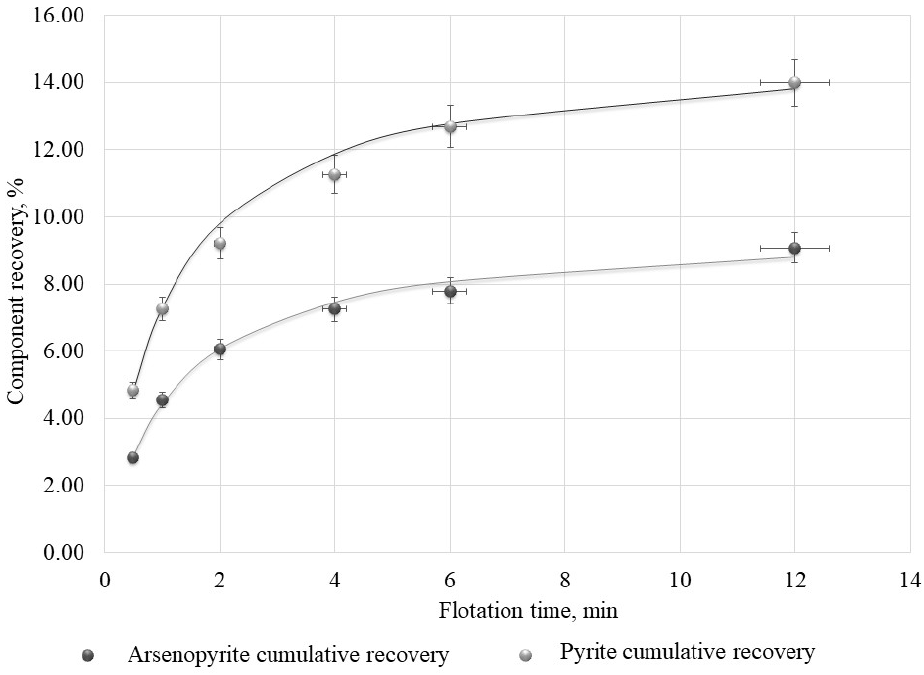
Figure 3. Recovery profiles for flotation without collectors.